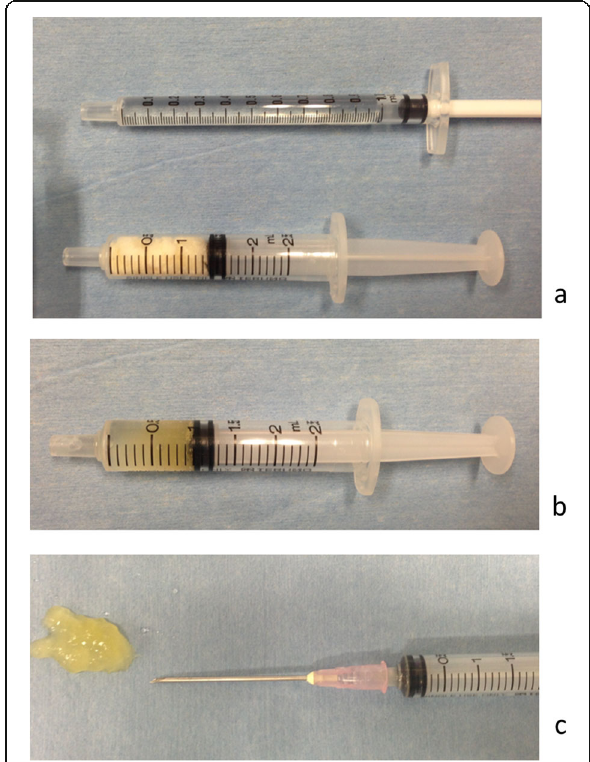
Fig. 2 Injectable gelatin hydrogel containing growth factor. The growth factor solution is impregnated in gelatin hydrogel to create a gel-form that can be percutaneously injected using a syringe. a Preparation of the growth factor solution (upper) and the freeze- dried gelatin (lower). b A gel-form of growth factor-impregnated gelatin hydrogel inside the syringe. c Injected gel-form containing growth factor